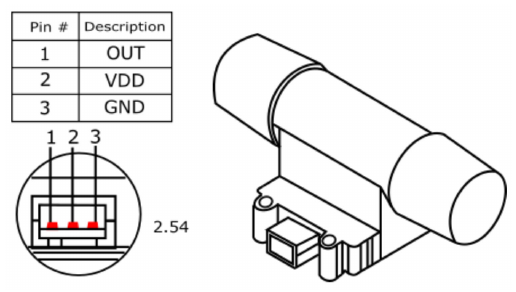
Figure 5. Flow sensor from PMF4101V